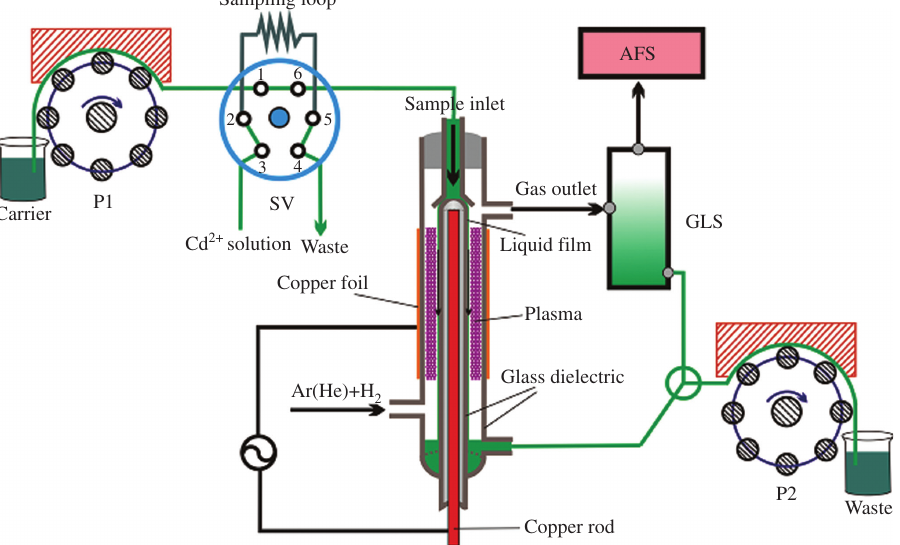
Figure 5 Schematics diagram of the instrumental setup of the FI thin-film DBD plasma-CVG-AFS. P1, P2, peristaltic pump; SV, six-port valve. Reproduced with permission from Zhu et al. (2013b). Copyright 2013 American Chemical